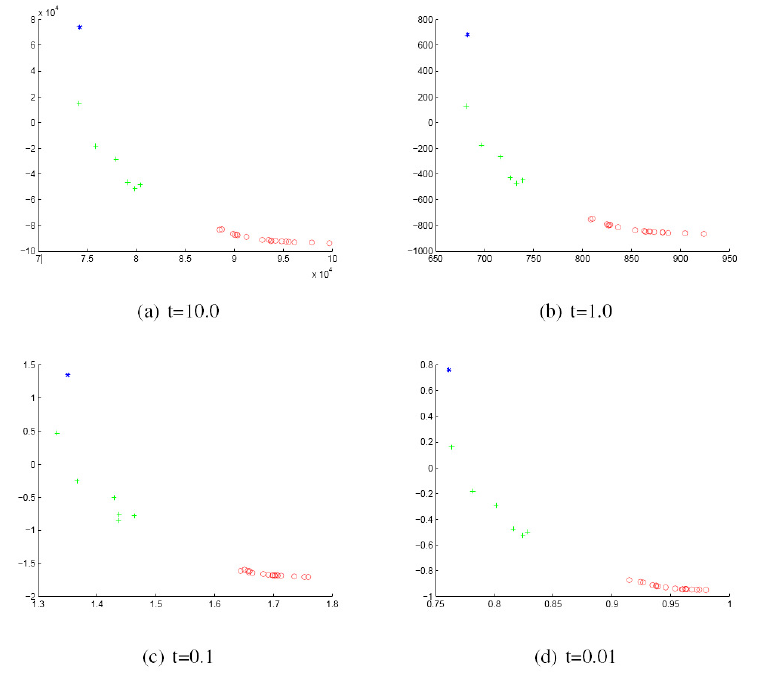
Figure 9. MDS embedding obtained using MHD for COIL data represented by the Gaussian curvatures associated with each node. The x and y axes are the embedding coordinates corresponding to the leading two dimensions of the MDS embedding. The differently-coloured symbols denote different object